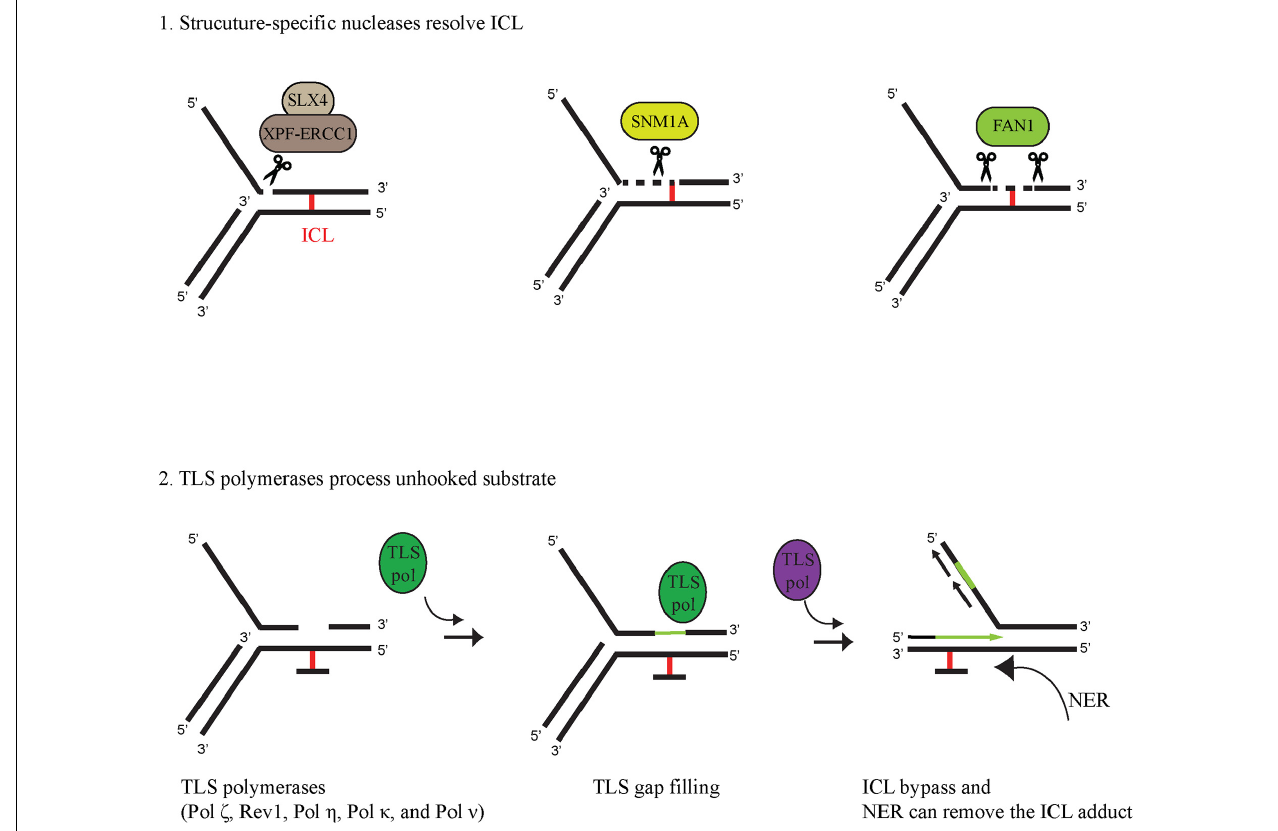
FIGURE 2 | Coordinated activity of structure-specific nucleases and TLS polymerases in ICL bypass (1) Structure-specific nucleases unhook ICL-containing DNA. SLX4 serves as a scaffold protein for XPF-ERCC1 to digest the dsDNA phosphodiester bond at the 5 (cid:48) primer of the junction between dsDNA and ssDNA. The digested substrate can be further processed by the 5 (cid:48) -3 (cid:48) exonuclease activity of SNM1A. FAN1 can completely unhook the ICL-containing substrate due to its 5 (cid:48) -3 (cid:48) endo/exonuclease activity. (2) TLS polymerases can process the unhooked ICL-containing DNA by filling in the gap generated by ICL-unhooking nucleases and